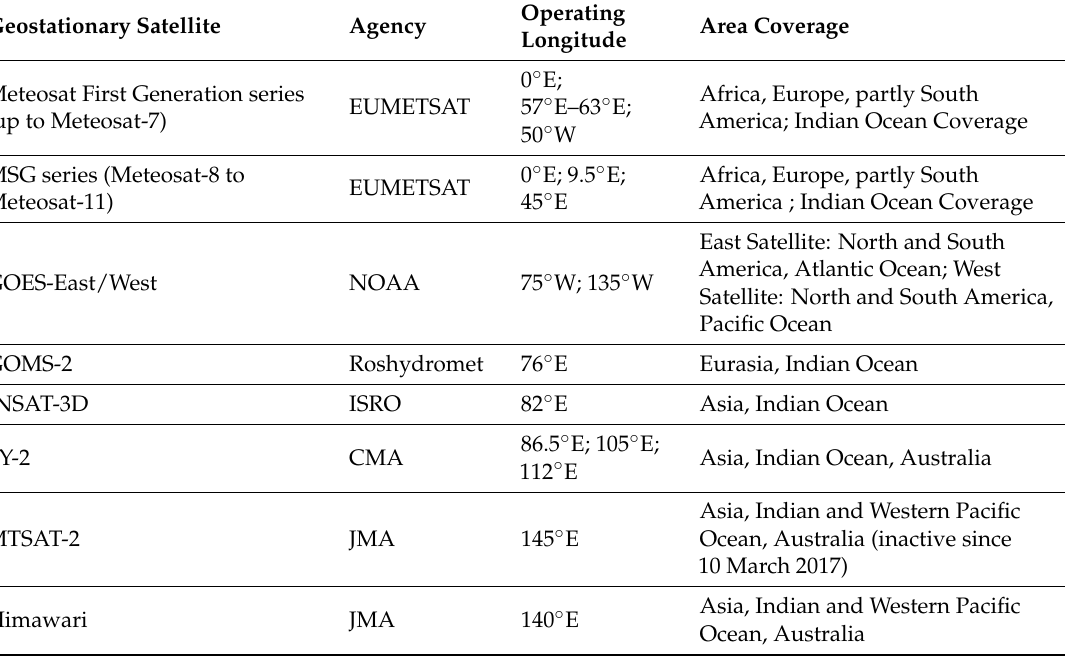
Table 2. Geostationary satellites operated positions as of 2018. Operational position can vary over